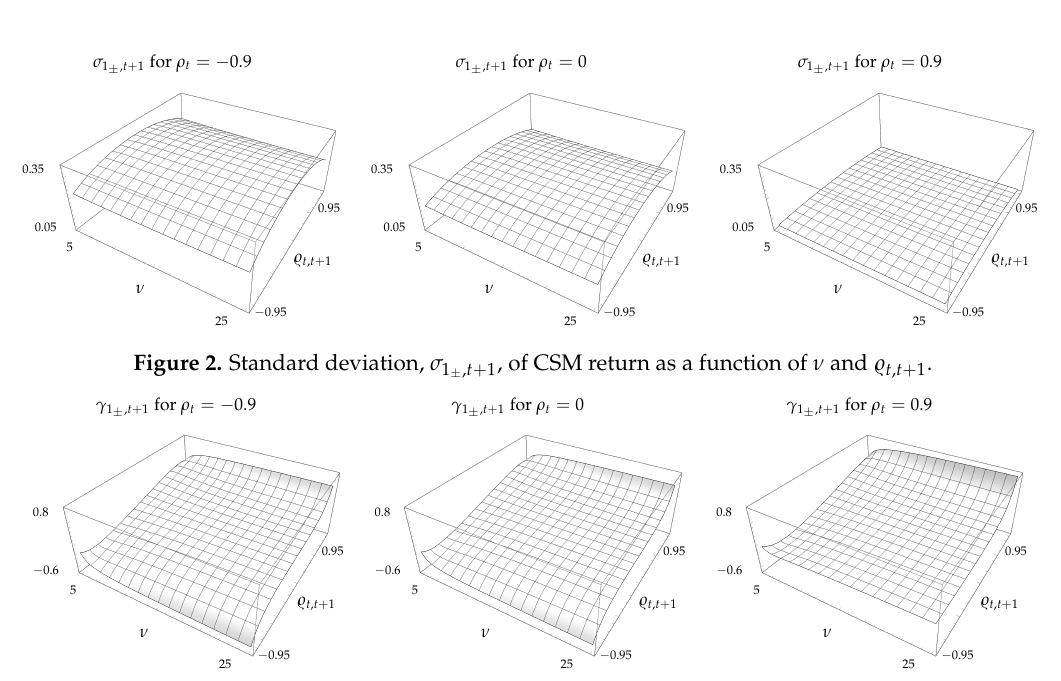
Figure 3. Skewness, γ 1 , of CSM return as a function of ν and (cid:36) t , t + 1 . ± , t + 1